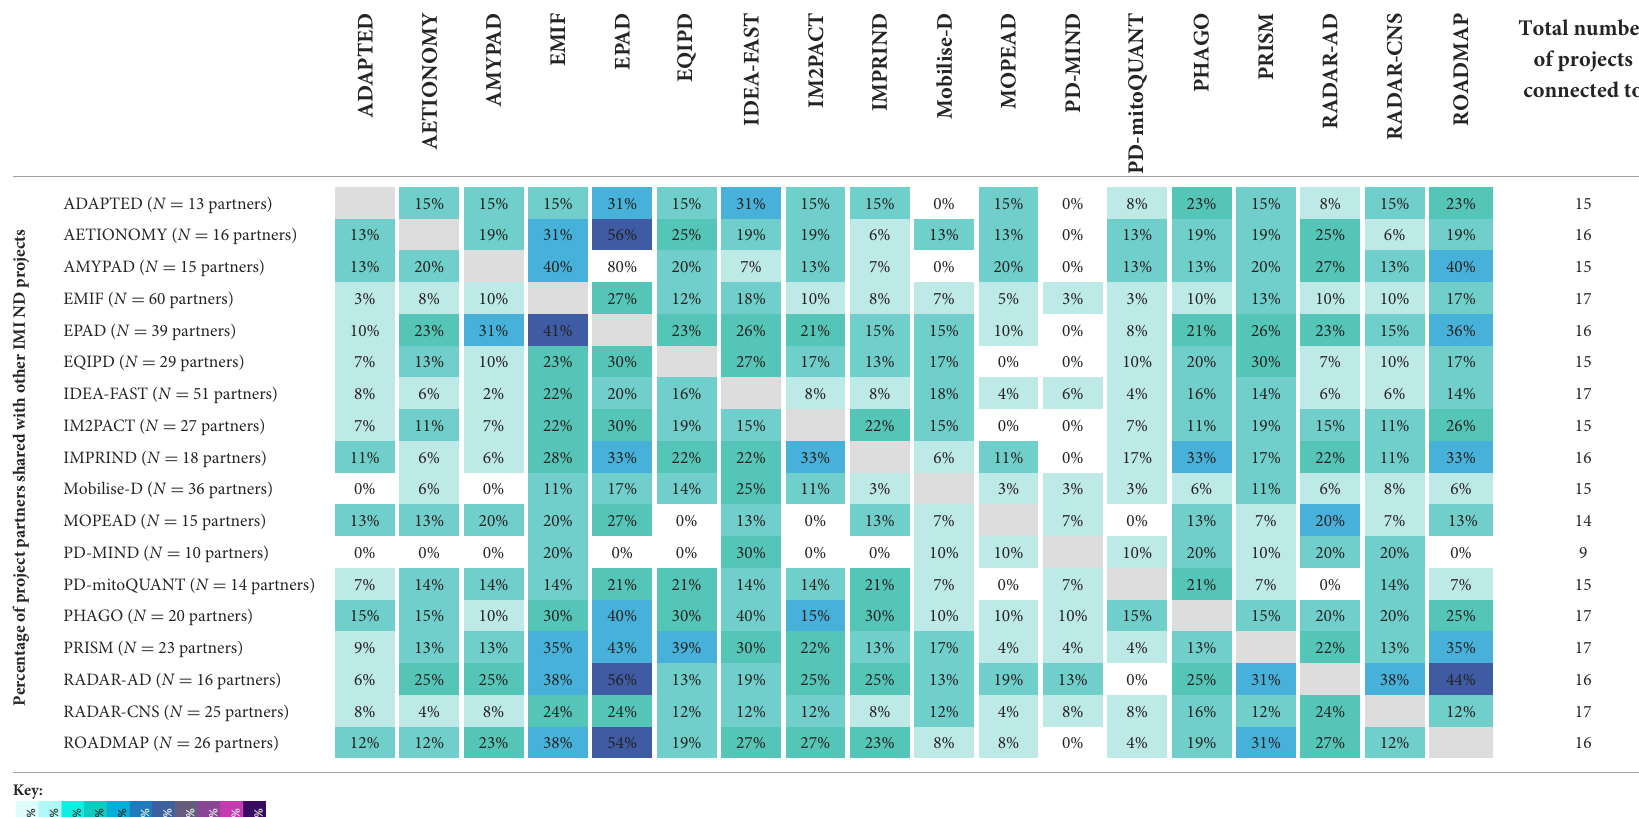
TABLE 4A Percentage of project partners shared between IMI NDD projects (including